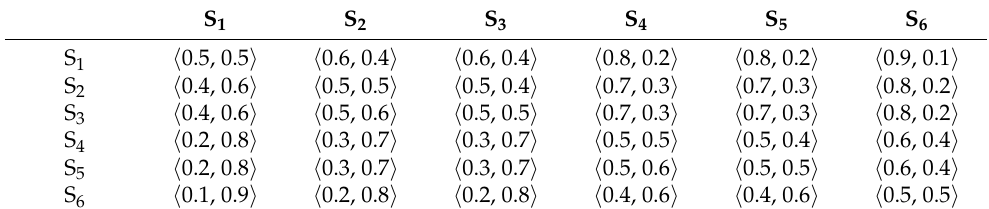
Table 6. Aggregated decision matrix in PF–AHP for the sub-criteria S ( CI = 0.0426034, CR = 0.0343576). S 1